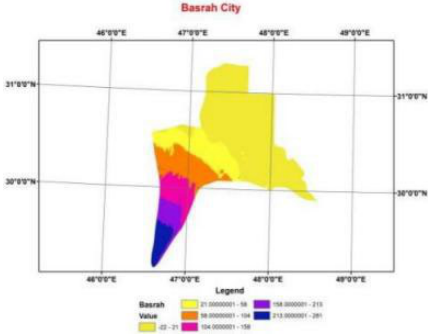
Figure 5. Map showing the ALOS World 3D – 30 m of the Basrah city